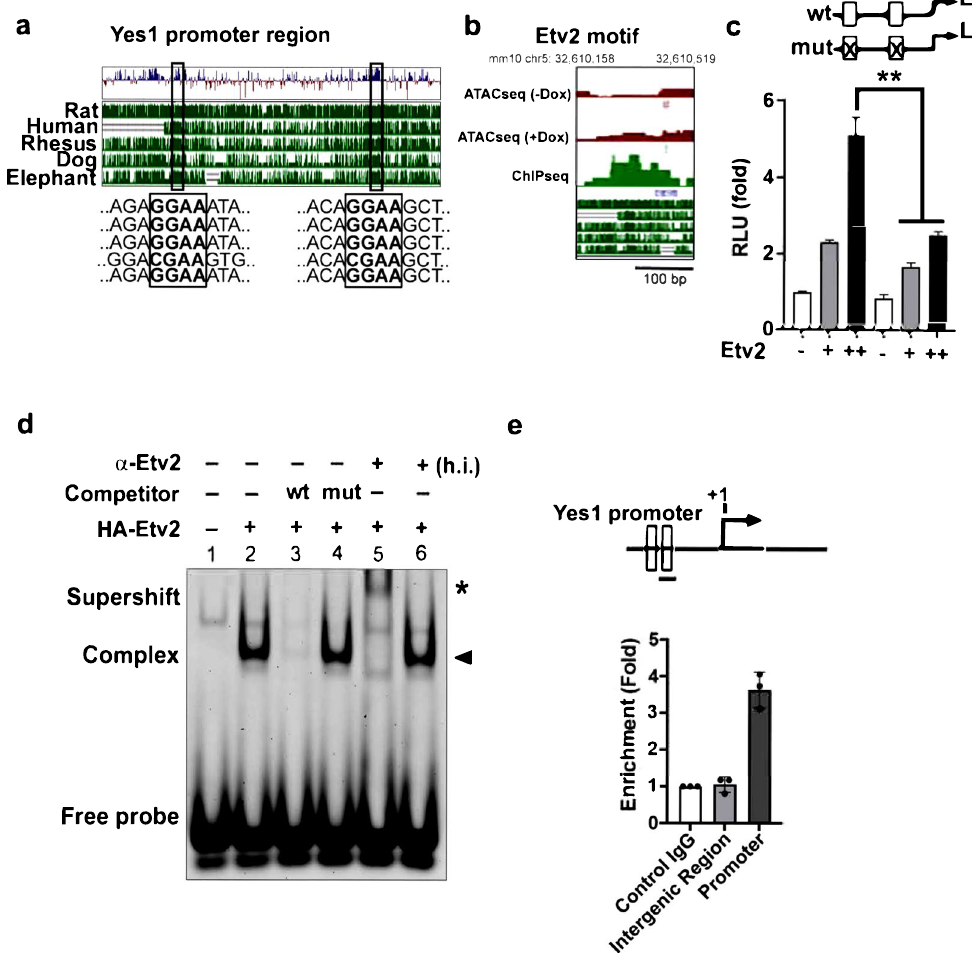
Figure 5. Yes1 is a downstream target of Etv2 . ( a ) Evolutionary conservation of the 5.0 kb upstream promoter fragment of the Yes1 gene. Note the high conservation of the Etv2 binding motif across various species. ( b ) Alignment of ATACseq peak and ChIPseq peak within the Yes1 upstream region. ( c ) Luciferase reporter constructs using the Yes1 promoter (0.5 kb) harboring wildtype (wt; open box) or mutant (mut; crossed box) Etv2 binding sites. Etv2 enhanced the transcriptional activity in a dose-dependent manner. ( d ) EMSA showing Etv2 bound to the Ets binding site in the Yes1 promoter region. IRdye-labeled probes containing the putative binding sites were incubated with in vitro synthesized HA-ETV2 protein to form a specific complex with the oligo (lane 2; arrowhead), which is competed with wildtype unlabeled oligos (lane 3) but not with mutant (lane 4). Addition of the HA-antibody supershifted the complex but not with heat-inactivated (h.i.) antibody (asterisk), indicating specificity of the complex. ( e ) Top: Schematic of the upstream region of the Yes1 promoter showing the Etv2 binding sites (open boxes). Bottom: ChIP analysis of D4 Dox-inducible iHA-Etv2 EBs using an HA antibody. ChIP assay for the Gapdh promoter was used as a control. ChIP assay using an intergenic region was performed to validate the specificity. Data are presented as mean ± SEM (n = 3 replicates; ** p <